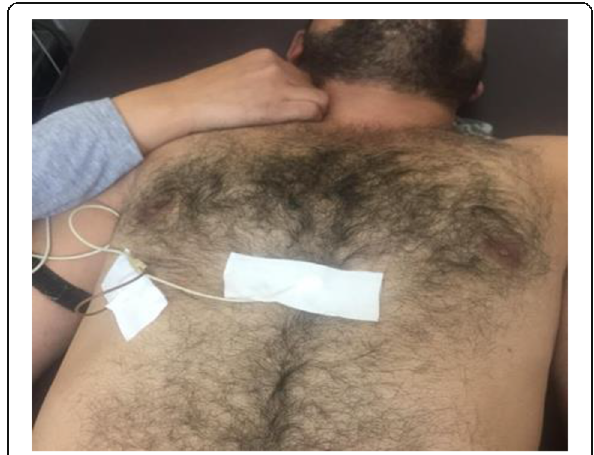
Fig. 1 Application of recording electrodes for phrenic NCS